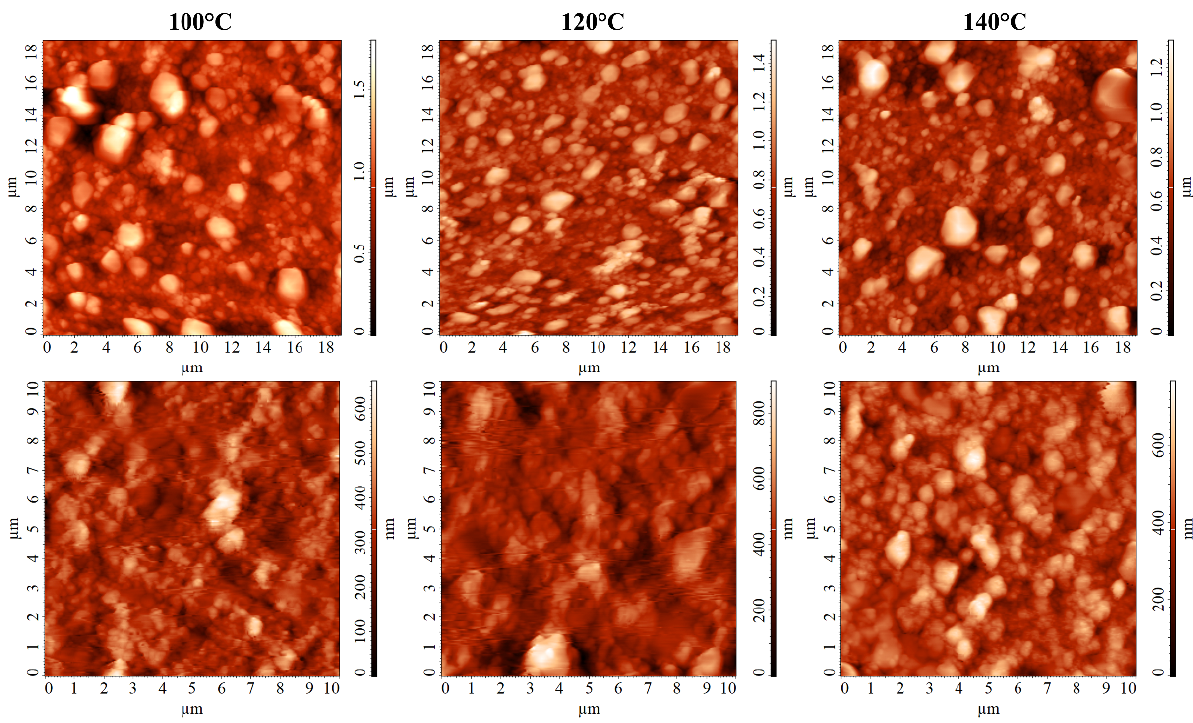
Figure 6. AFM micrographs of Ag films grown at different temperatures ( top —the main surface; bottom —dark areas).